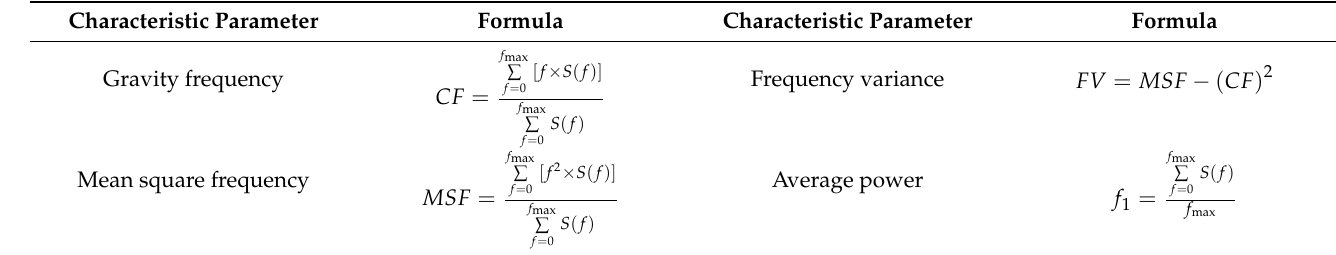
Table 2. Frequency-domain characteristic